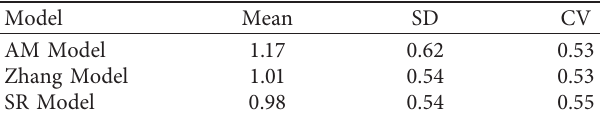
Table 11: The statistics of calculated ε under concrete surface failure mode.